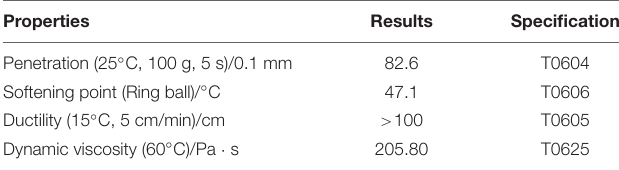
TABLE 1 | Basic properties of neat asphalt.